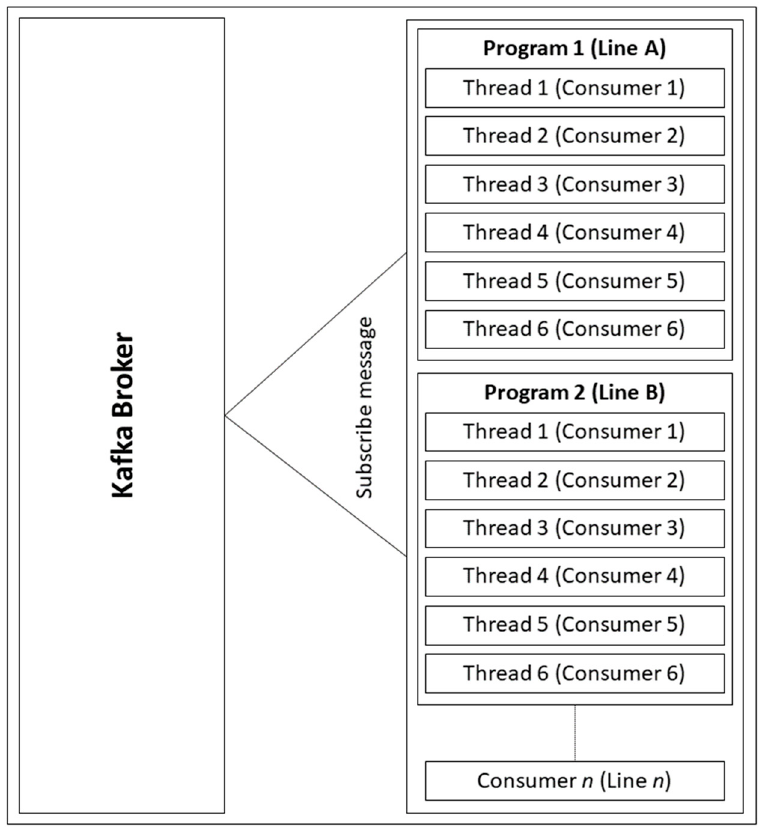
Figure 6. Multi-threading in Kafka Consumer Program.